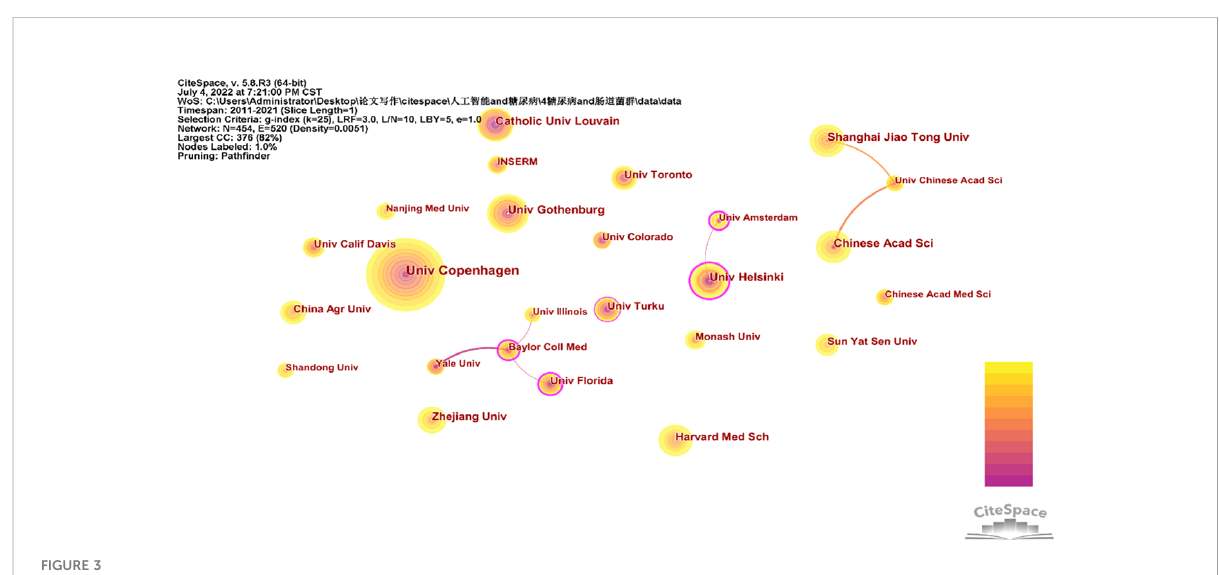
FIGURE 3 Cooperation network between major institutions.